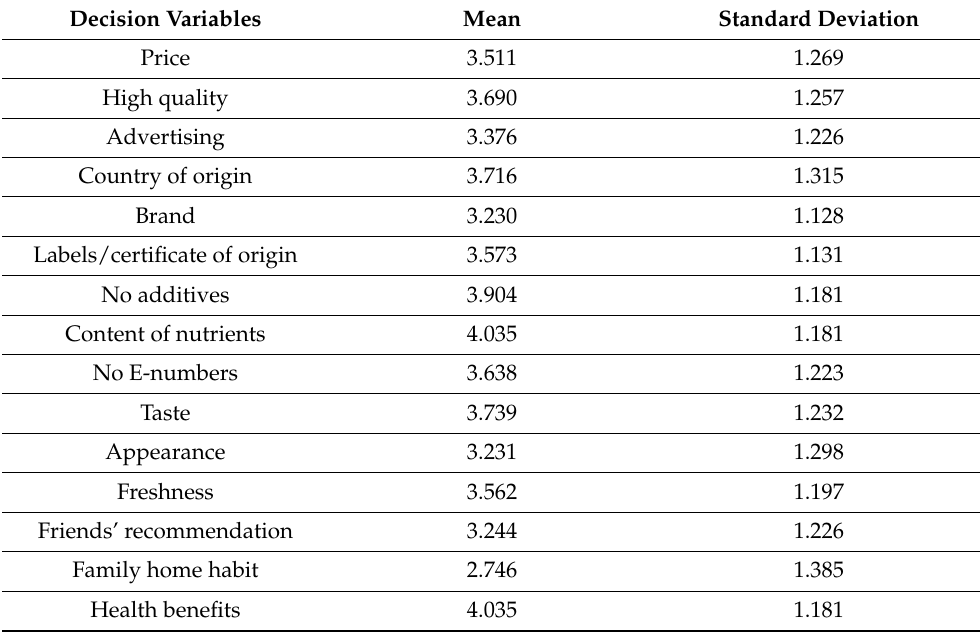
Table 2. Decision variables considered by consumers when buying organic food